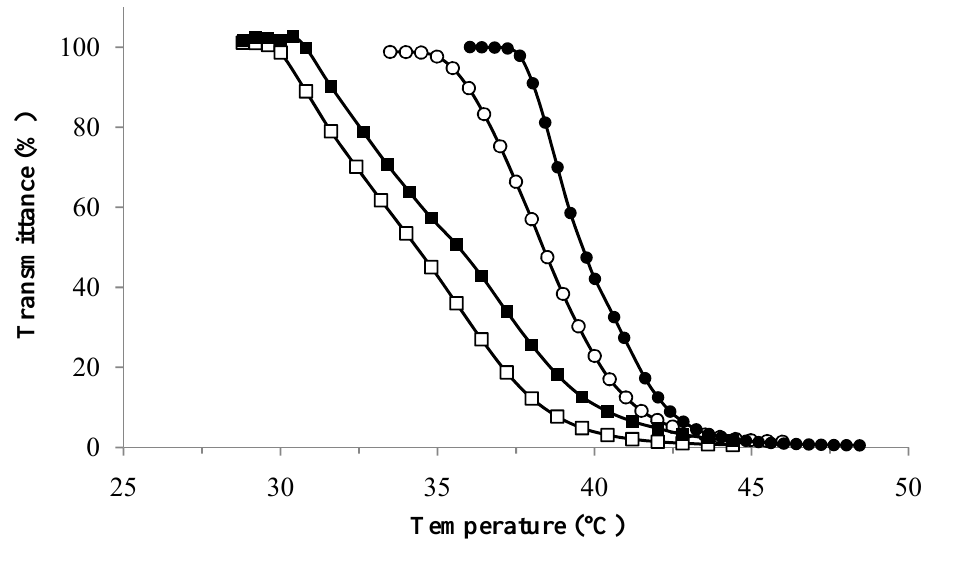
Figure 6. Phase transition profiles of 1 + 3 ( ■ ), 2 + 3 ( □ ), 1 + 4 ( ● ) and 2 + 4 ( ○ ). (Polymer concentration used = 1